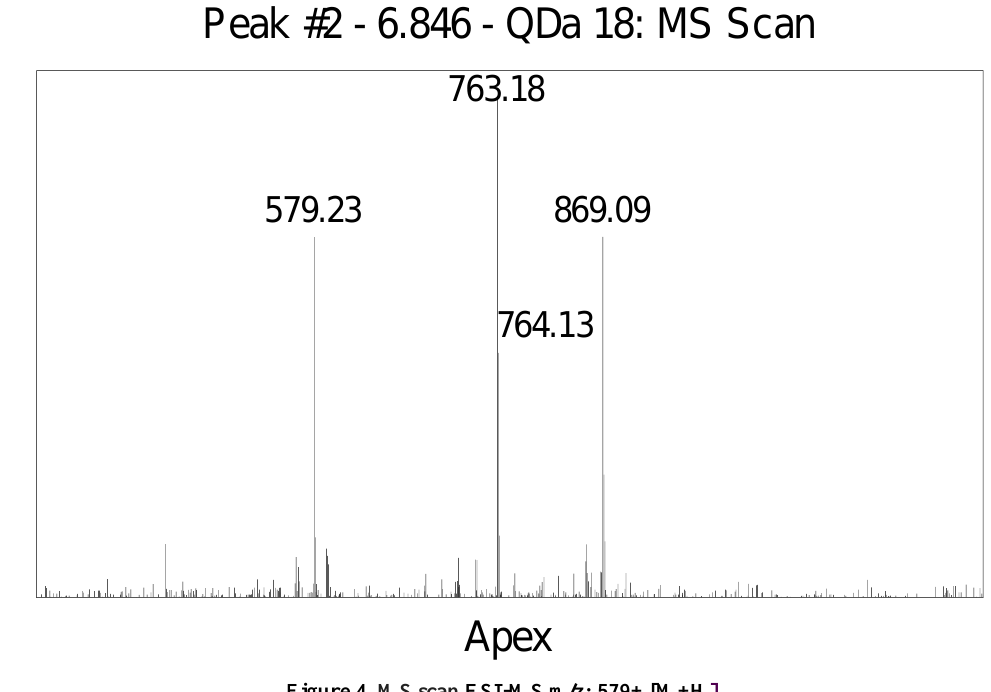
Figure 4. MS scan ESI-MS m/z: 579+